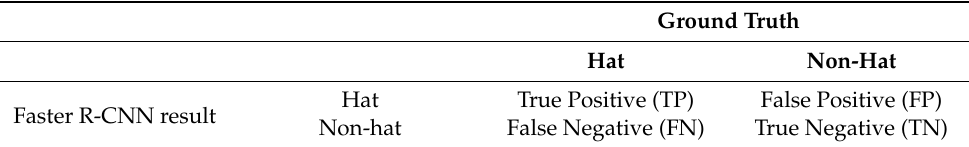
Table 1. Performance assessment of Faster R-CNN in this